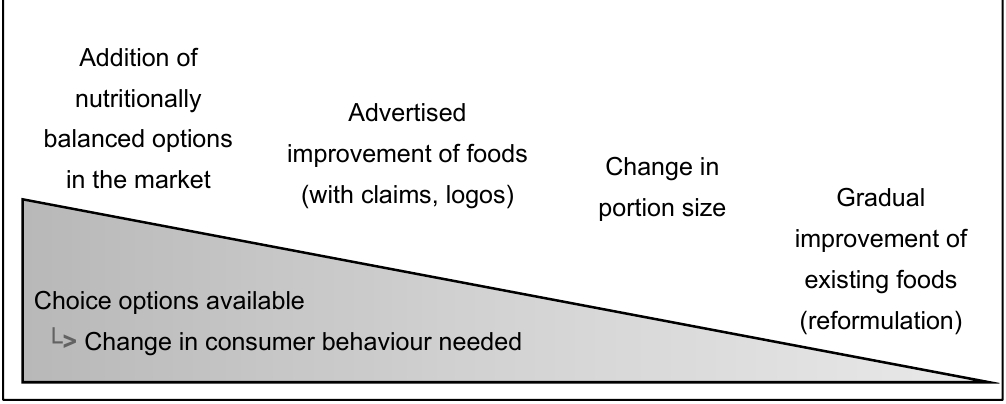
Figure 1. Classifications of strategies changing the characteristics of food available for a population along a gradient of change in consumer behaviour needed to get a benefit from the new food products.